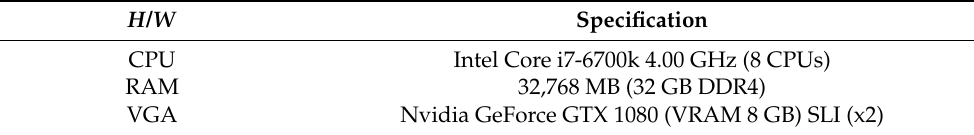
Table 1. Computer performance for